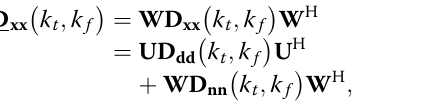
Fig. 1, the auto-term of the weak signal cannot be